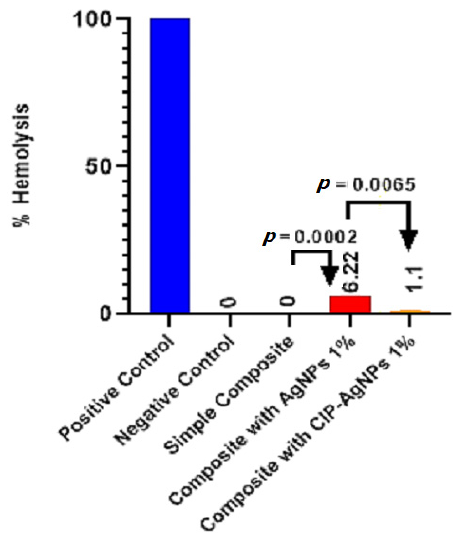
Figure 9. Hemolytic activity of experimental composite discs.